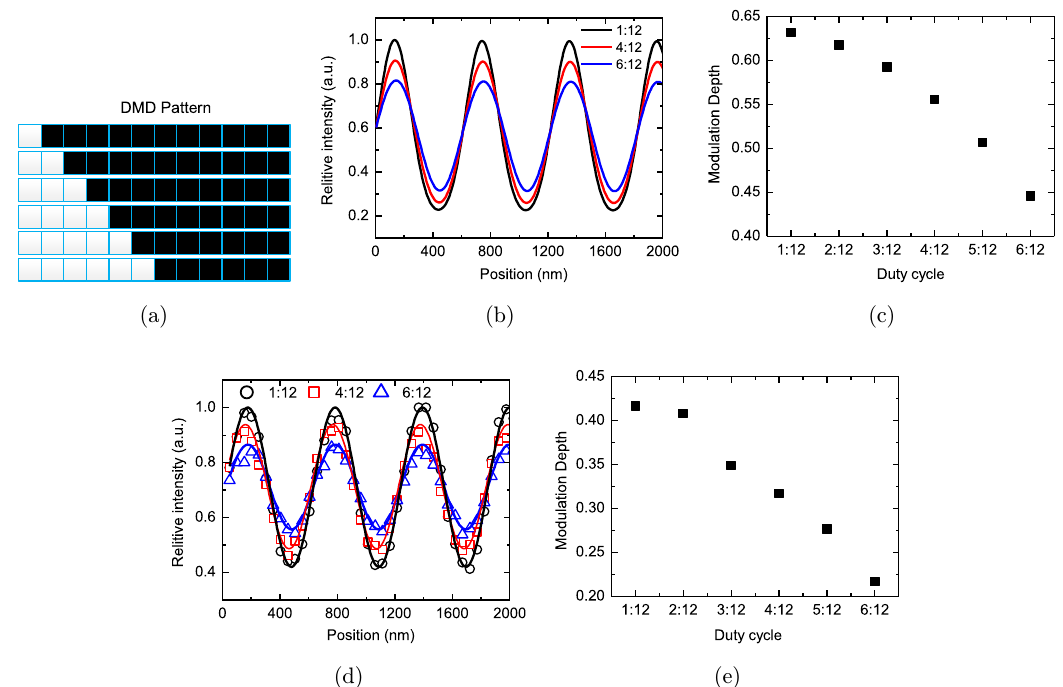
Fig. 5. Evaluation of the di®erent duty cycle but same period on the modulation depth. (a) Binary patterns loaded on the DMD chip; (b), (c) the calculated normalized intensity distribution obtained at the focal plane of the objective and modulation depth with di®erent duty cycle; (d), (e) the corresponding intensity distribution and modulation depth experimentally measured in our setup.